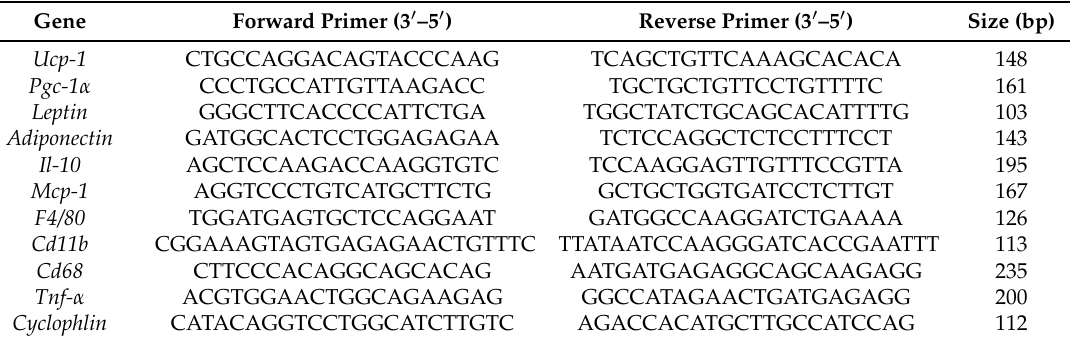
Table 1. Primers used for quantitative real-time PCR